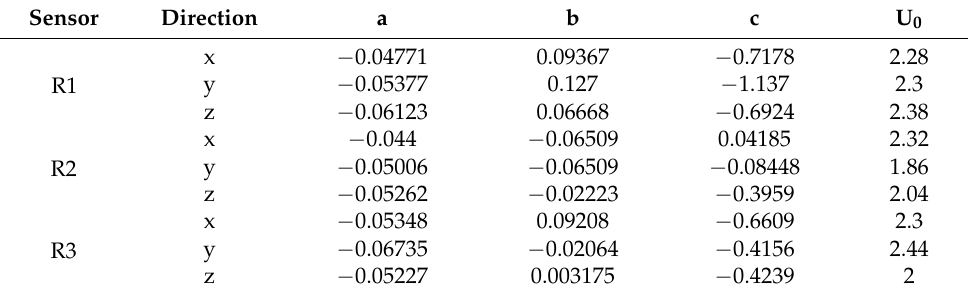
Table 1. Parameters of the SmartRock for stress conversion.